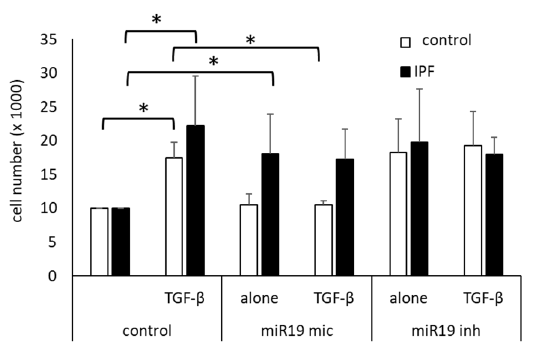
Figure 3. Modification of miR-19a-3p on cell proliferation. Proliferation was determined 2 days after stimulation with 10 ng/mL TGF- β 1 (TGF- β ), and in non-treated cells. Prior to the stimulation, cells were transfected with either a mimic of miR19a-3p (miR19 mic) or an inhibitor of miR-19a-3p (miR19 inh). Bars represent the mean ± SEM of cell counts obtained in 5 control fibroblast lines and of 5 IPF cell lines. p -values were calculated by Student’s t -test (2 sided paired): * indicates p < 0.05. TGF- β : TGF β 1 (10 ng/mL); miR-19a-3p mimic vector: miR19; miR-19a-3p inhibitor: miR19 inh.